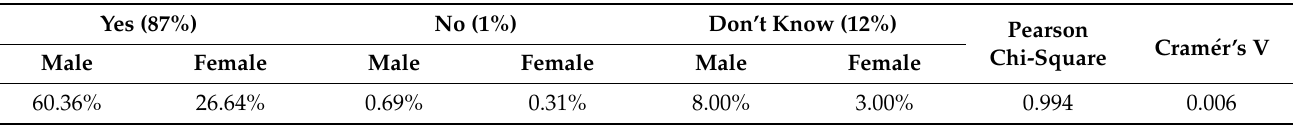
Table 9. refer back to Figure 3. Gender * Vulnerability to_ women, children, the elderly and the disabled are most vulnerable to climate change -Cross tabulation.